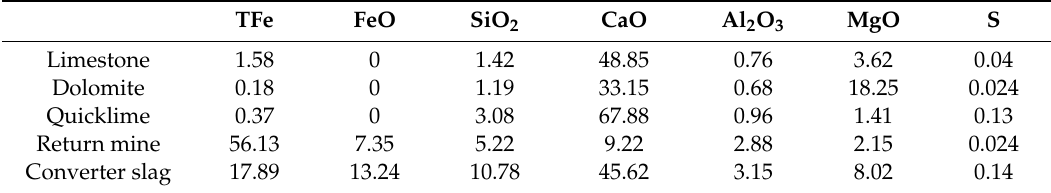
Table 3. Composition of flux, return mine, and converter slag [16].